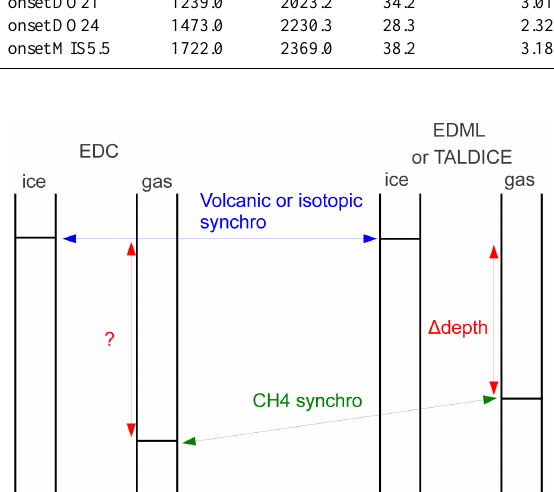
Fig. 5. Scheme illustrating the deduction of the 1 depth at EDC from ice (volcanic) and gas (CH 4 ) synchronisation to the EDML or TADLICE ice cores and evaluation of 1 depth at EDML or